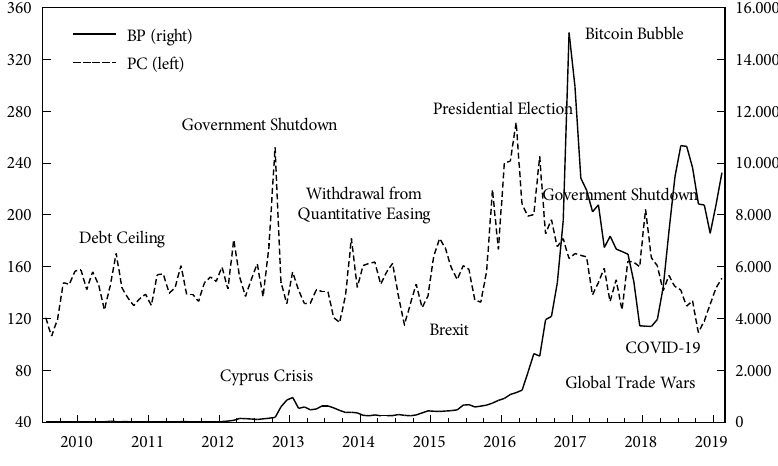
Figure 1. The trends of BP and